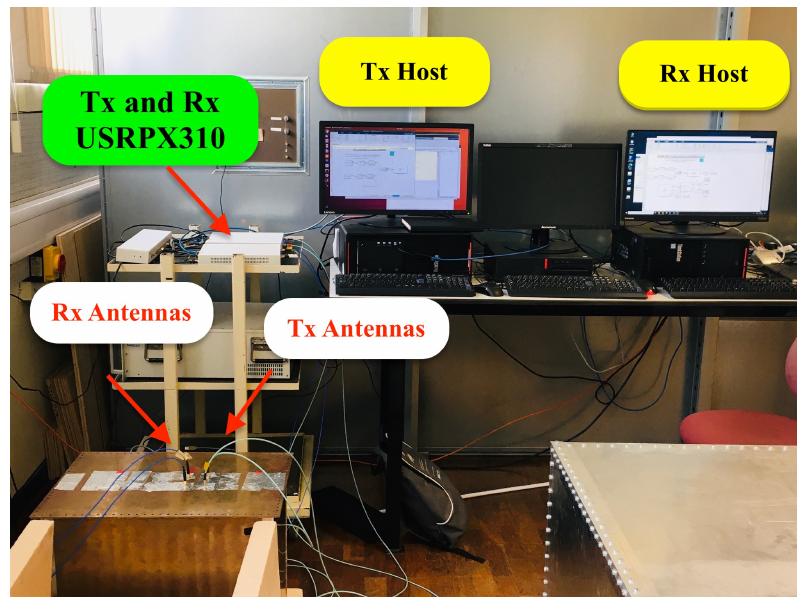
Figure 1. Overall USRP-based 2 × 2 near-field MIMO measurement setup for BER and EVM